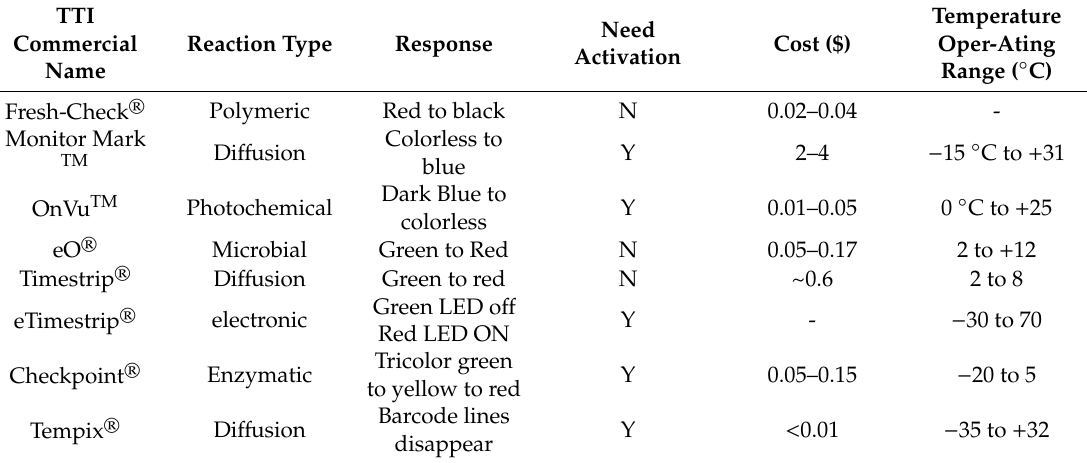
Table 6. Comparison between commercially available